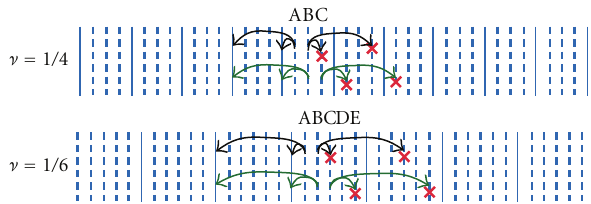
Figure 14: All Coulomb transitions from nearest hole pairs are